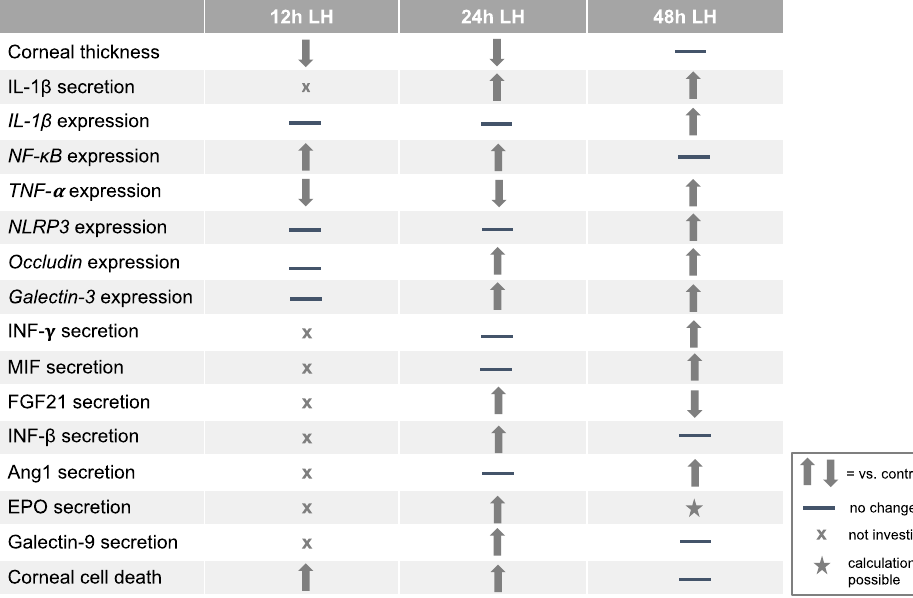
Figure 7. Table summarizing the results of ex vivo porcine corneal incubation at LH for 12 h, 24 h and 48 h. An increase or decrease in each factor was considered when the comparison between LH and HH was statistically significant, or in the case of the Cytokine Antibody Array when the ratio LH/HH was lower than 0.5 or higher than 1.5.